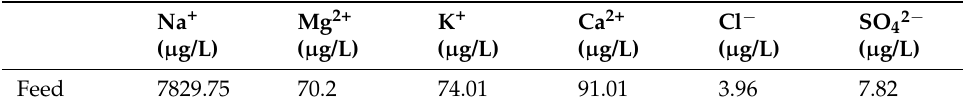
Table 2. Main components of mineralized wastewater.